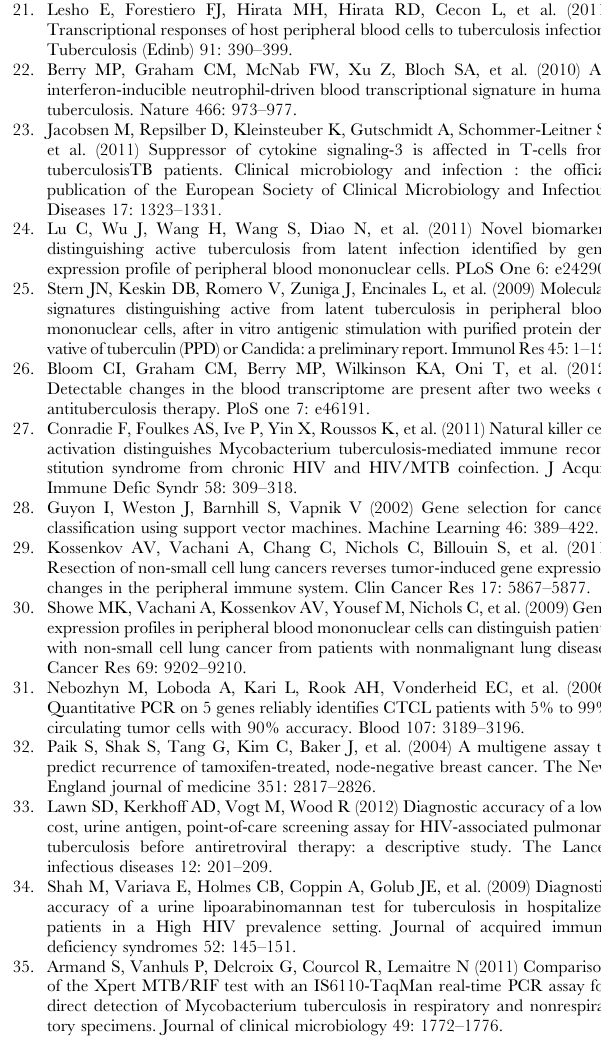
Figure S4 Performance of SVM signature in additional testing sets. Classification scores assigned by the SVM based on the 251 gene signature to classify active TB (positive scores) and controls (negative scores) in A-B) Test Sets 3 and 4 (UK) classifying TB patients (white), latent TB (black) and controls (grey); and C-D) Test Sets 5 and 6 (South Africa) classifying TB patients (white) and latent TB (black). The inserts in each figure show zoomed-in regions of the samples between the dashed vertical lines. Figure S5 Changes in expression of the 251 gene associated with treatment. Significant changes in the expression of the 251 gene signature occur within 2 weeks of treatment as shown by changes in A) Molecular Distance to Health in the South African cohort (median and interquartile range), B) Temporal Molecular Response in the South African cohort (mean and 95% confidence interval) and C) Temporal Molecular Response in the UK cohort (mean and 95% confidence